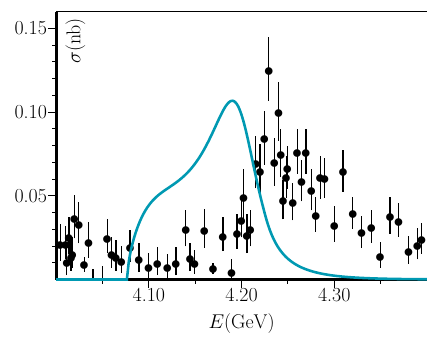
Figure 2. Channel J /ψ f 0 (980) compared to J /ψπ + π − data in Ref.